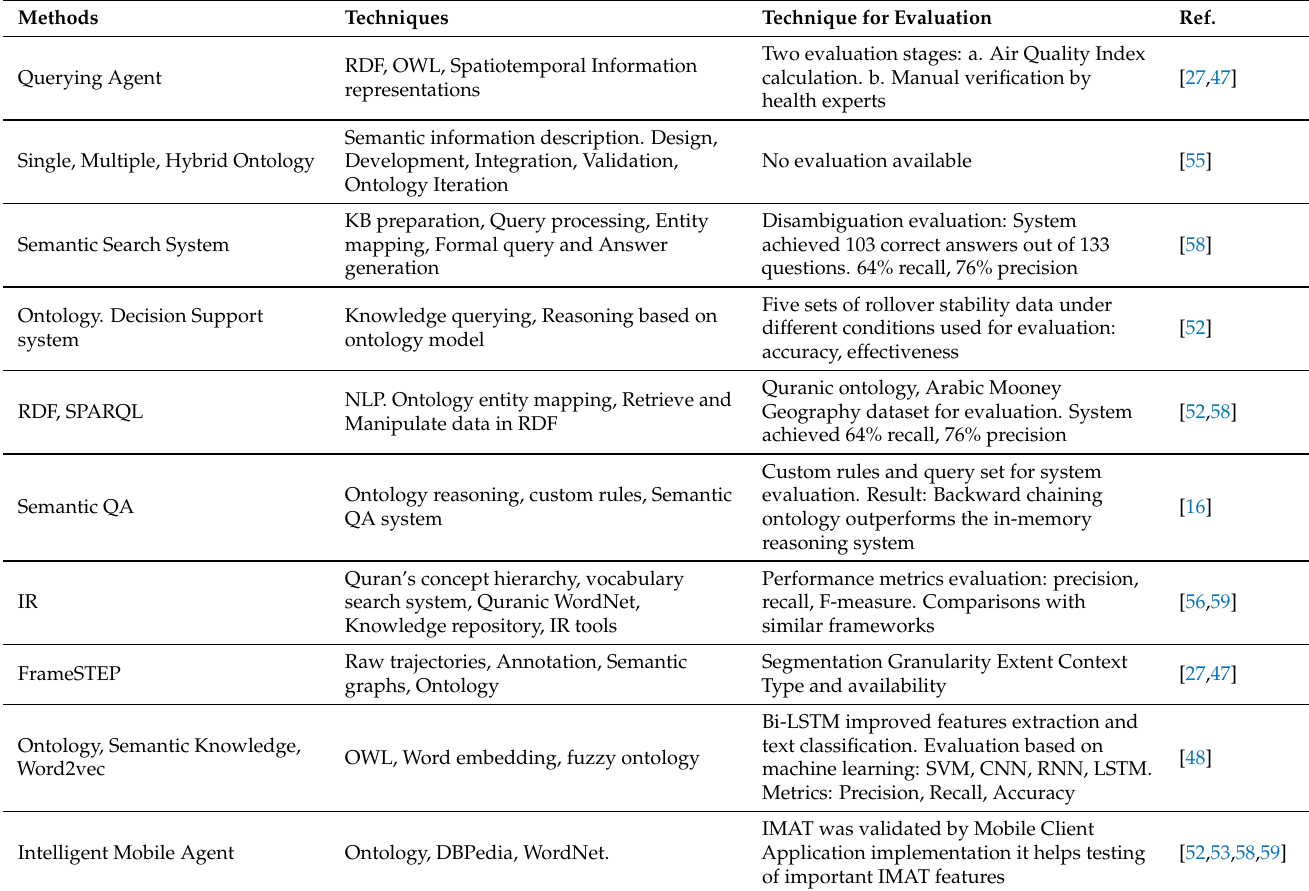
Figure 2. Flow of Search and Selection. Table 3. Methods and techniques identified for the related